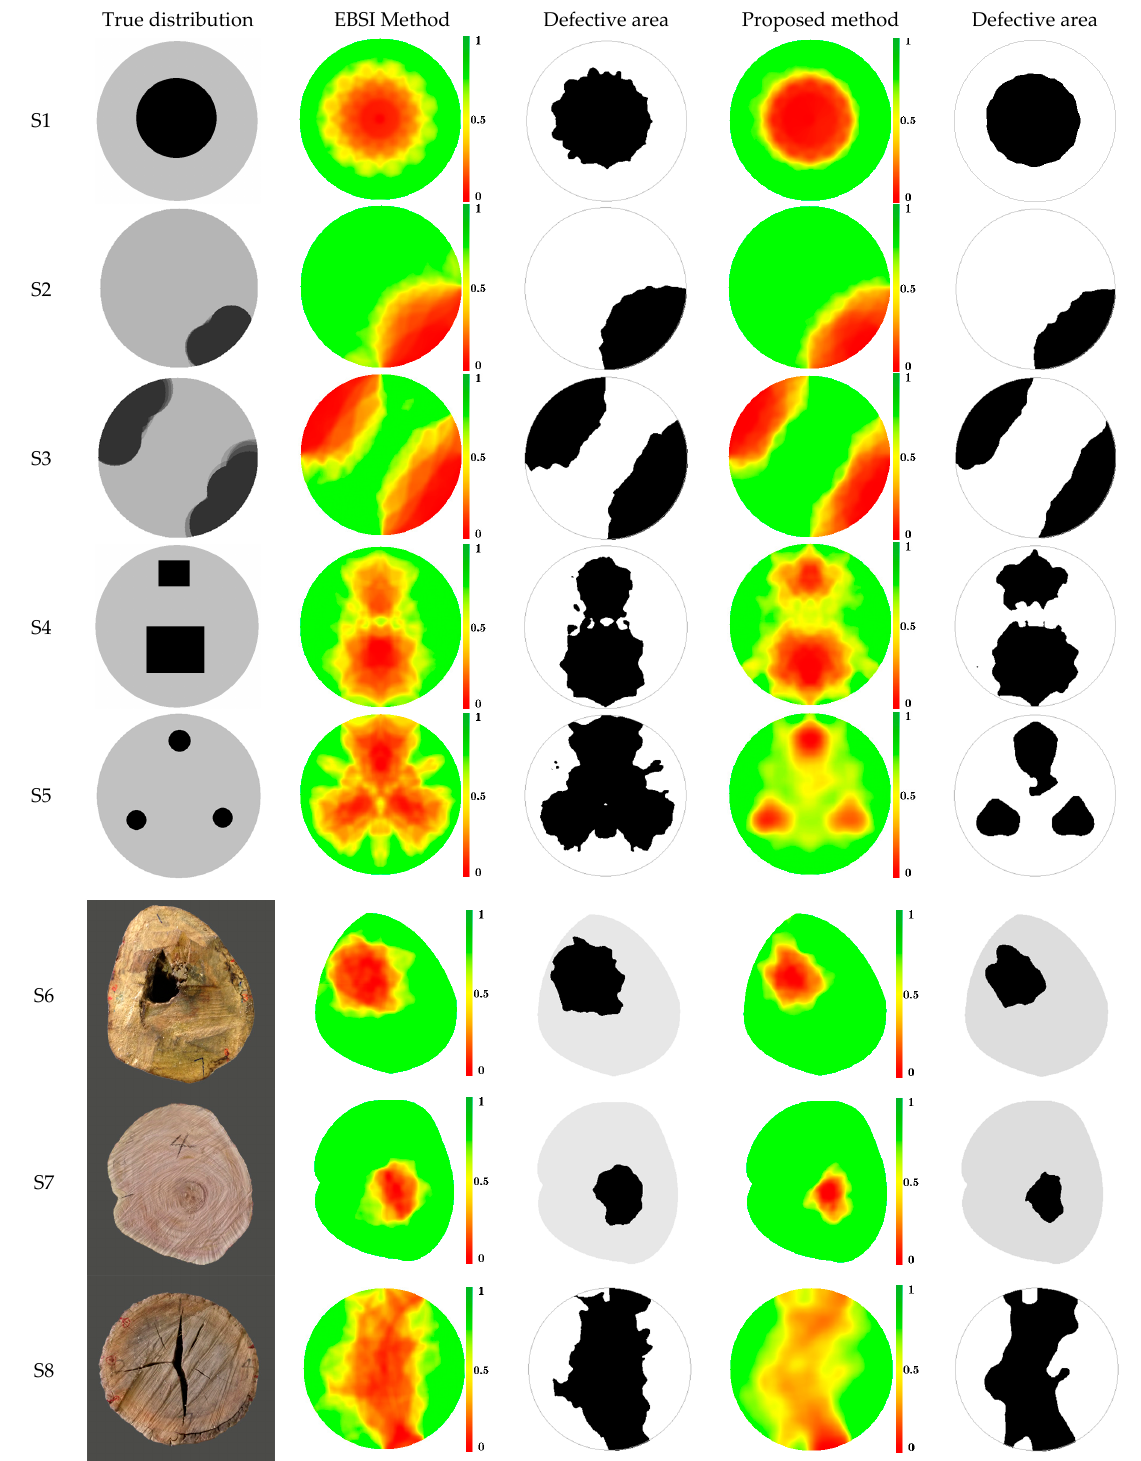
Figure 10. Images reconstructed with different algorithms and the corresponding defective area.